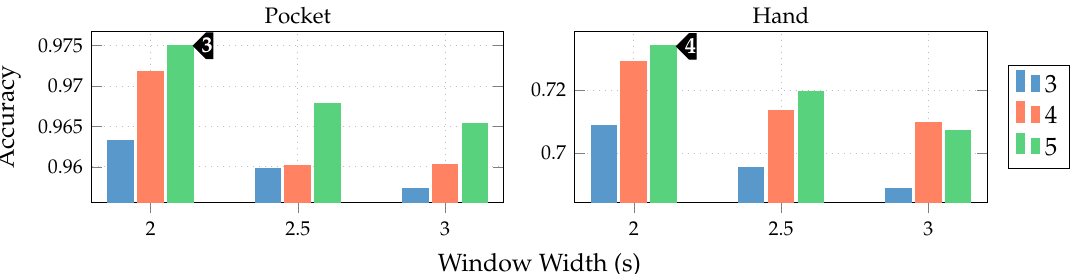
Figure 14. Resulting classification accuracies for the approach based on analytical transformations, with using the PCA at different window lengths and dimensions, on aligned acceleration data in the two-channel coordinate system described in Section 3.1.